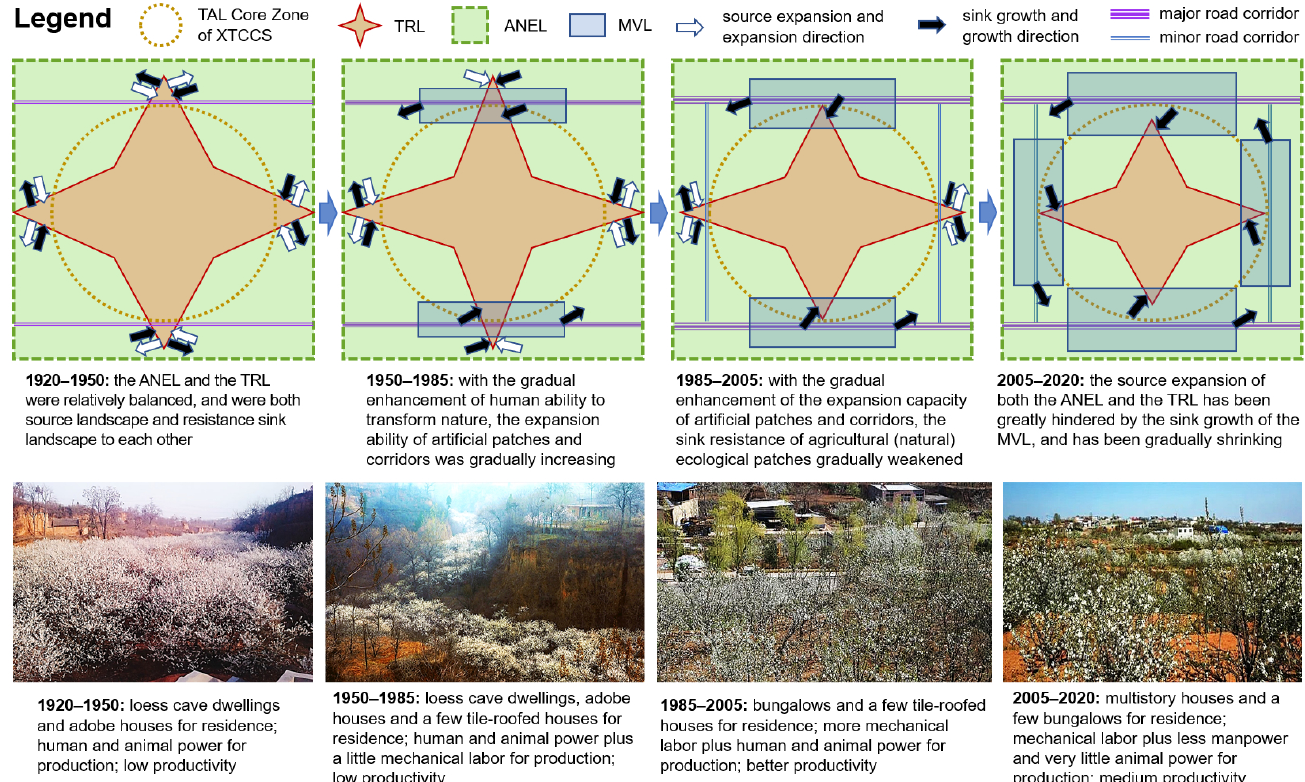
Figure 9. Source–sink structure and interaction process of the TAL Core Zone. The displayed photographs are the cherry landscapes of Matou Village for auxiliary confirmation.